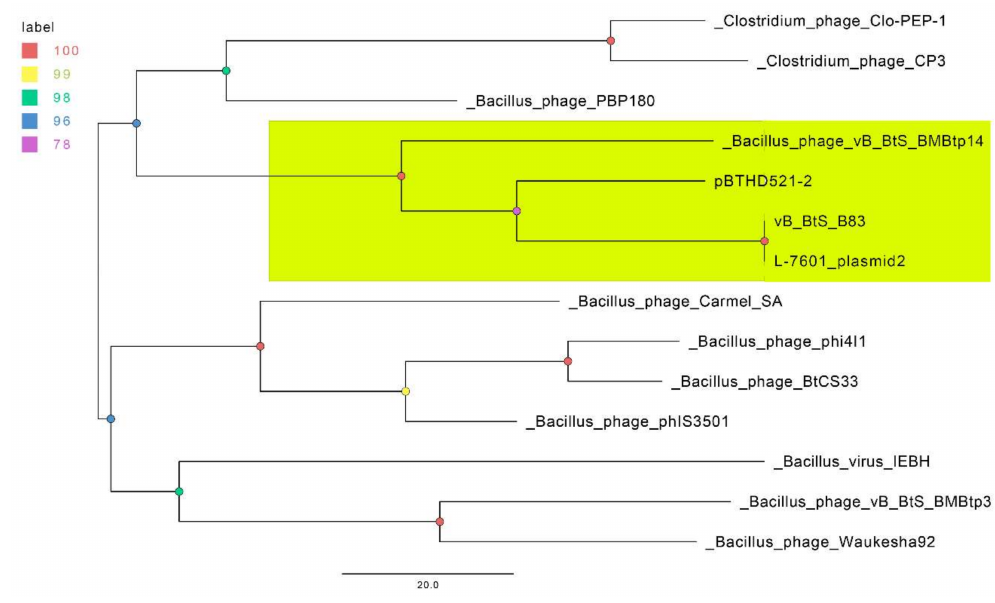
Figure 5. The parsimony pan-genome tree for 14 phage genomes derived from the presence / absence of homologous genes in a pan-genome matrix. The nodes are colored according to the legend, which represents standard bootstrap support values. The clade containing the members of proposed new genus is highlighted in yellow.